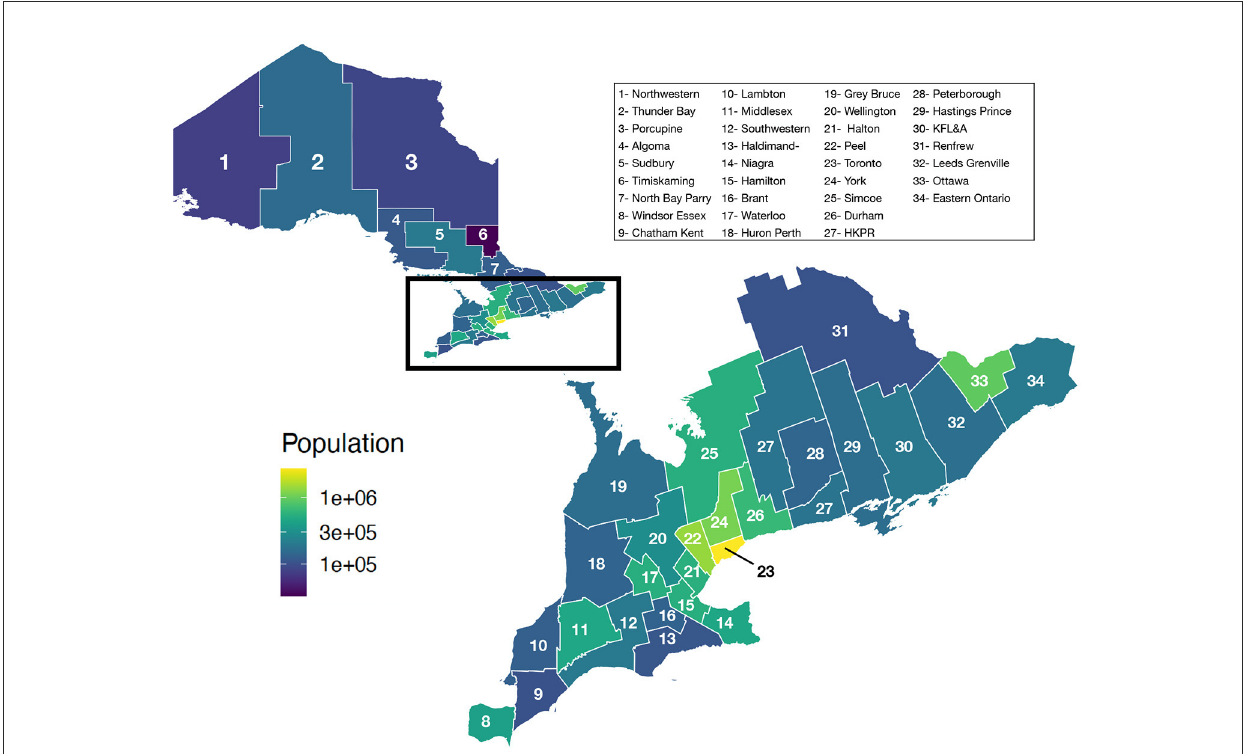
FIGURE1 Population of Ontario by